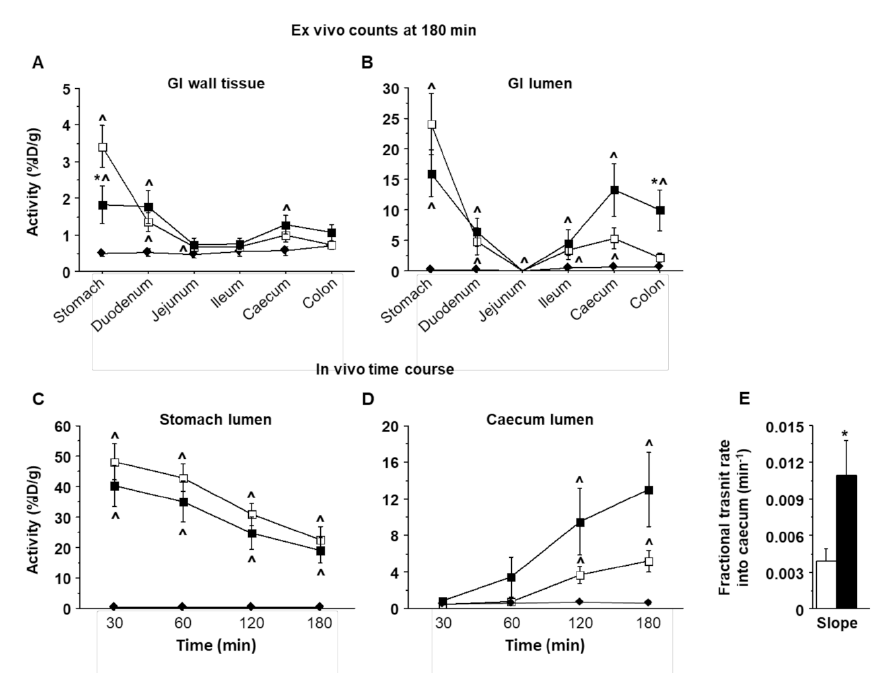
Figure 2. Gastrointestinal activity and transit rate: Top panels show 18 FDG activity levels, as recovered at the end of each study by ex vivo counting, either in the GI walls ( A ) or in the GI lumens ( B ), showing high levels of 18 FDG in the gastric wall after ingestion of glucose alone, and high levels of 18 FDG in distal lumens in the oral glucose + lipid protocol. Bottom panels show in vivo time courses of 18 FDG activity in the stomach ( C ) and caecum ( D ), as obtained by PET imaging, demonstrating greater tracer levels in the caecum during oral lipid and glucose co-administration than during glucose administration alone, as reflected by a several-fold difference in fractional transit rate constants ( E ), i.e., caecum inward rate constants estimated as slope (absolute activity values). Panels ( A – D ) include groups receiving i.p. glucose (black diamond), oral glucose (white square), and oral lipids + glucose (black square); panel ( E ) includes groups receiving oral glucose alone (white bar) or with lipids (black bar). Differences between consecutive walls ( A , B ), or changes over time ( C , D ) within groups were mostly significant; to limit figure complexity, these comparisons are not shown.